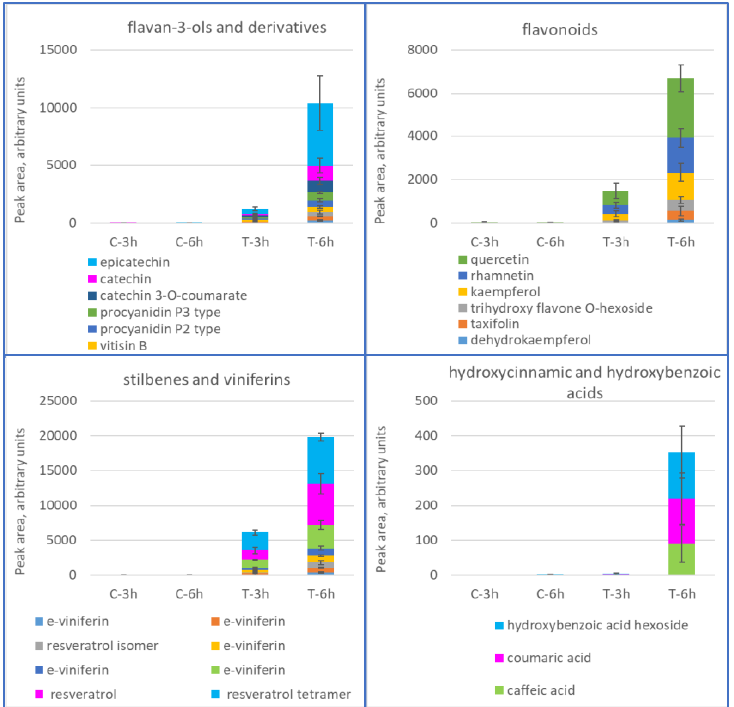
Figure 1. Principal component analysis of control cells (C) and cells pre-incubated with wine extract (T), according to their metabolite levels: ( a ) score plot and ( b ) loading plot. To set up the experimental procedure, 5, 10, and 20 millions of cells were used, and 1, 3, and 5 µ L of cell extract were analyzed.